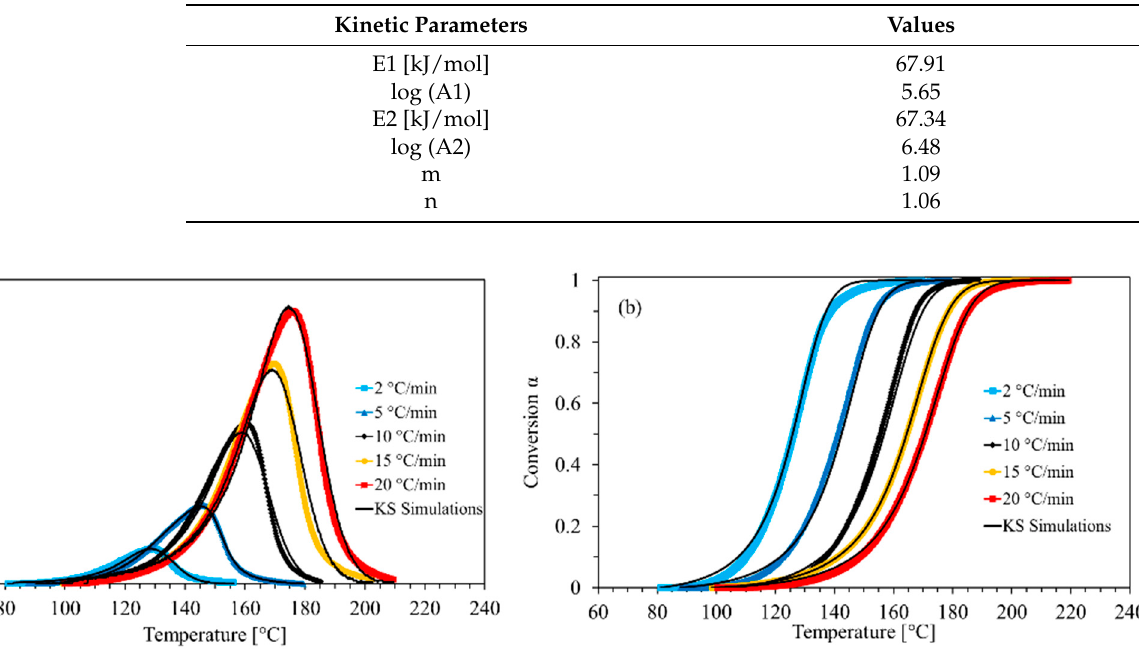
Figure 4. Plots of ( a ) conversion rate fit and ( b ) conversion fit of simulations after the Kamal-Sourour model and measured data at different heating rates.